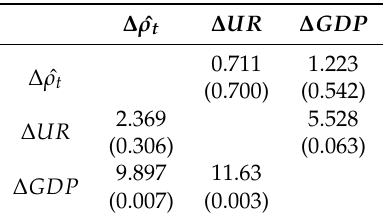
Table 2. The table reports the results of the Granger causality; χ 2 statistics of lagged first differenced term; in parentheses, the p -value.